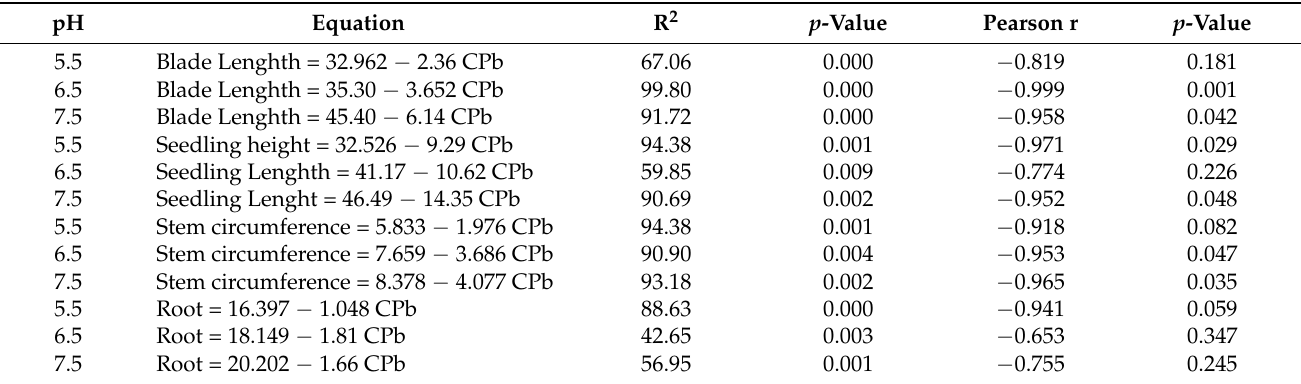
Table 5. Relationship of the maize leaf length, height of the entire plant, stem circumference, and length of the main root as a function of the lead concentration in the water CPb, at the three different pH levels at 60